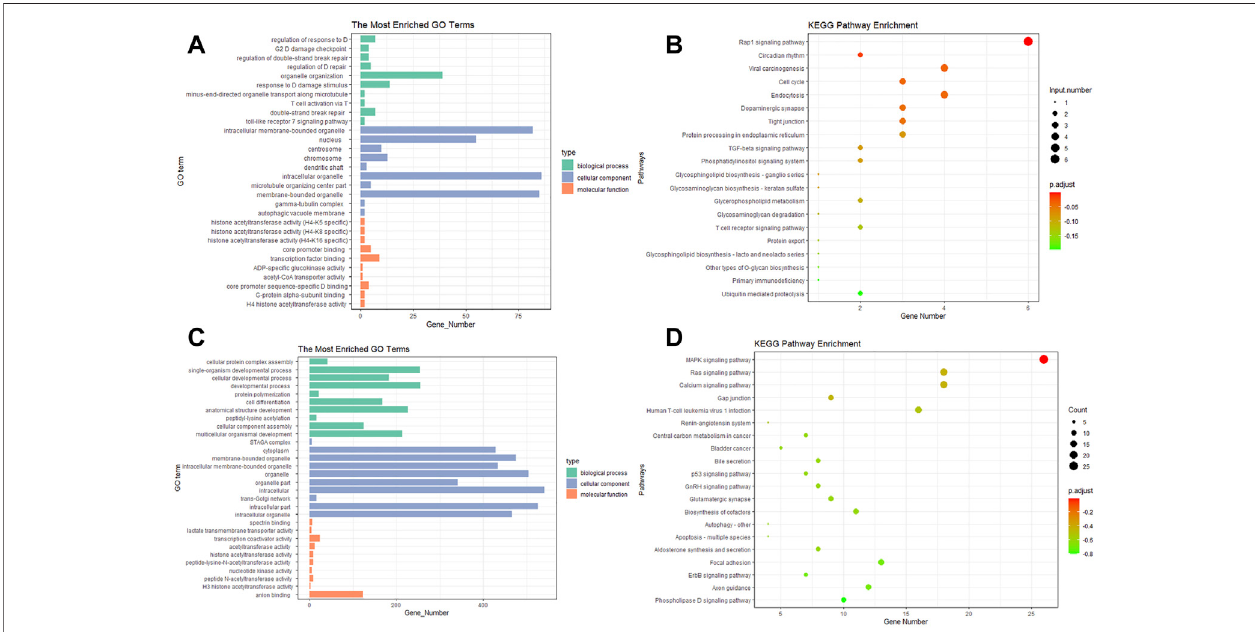
FIGURE 4 | Gene ontology and pathway analysis of the potential target genes (PTGs) of DE miRNAs and circRNAs. (A,C) GO analysis of miRNA and circRNA, respectively. (B,D) KEGG of miRNA and circRNA, respectively.